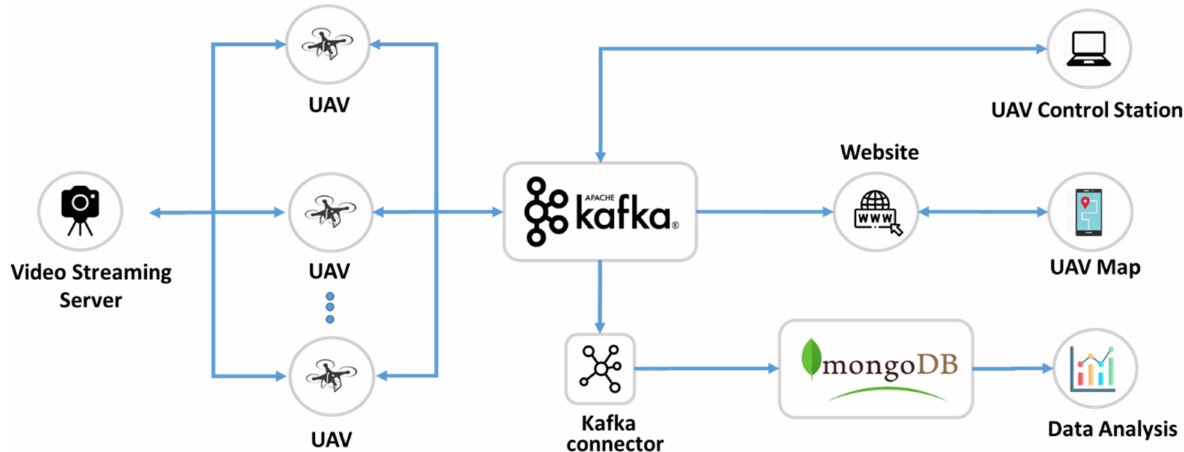
Figure 1. The structure of real-time unmanned aerial vehicle (UAV) trash monitoring